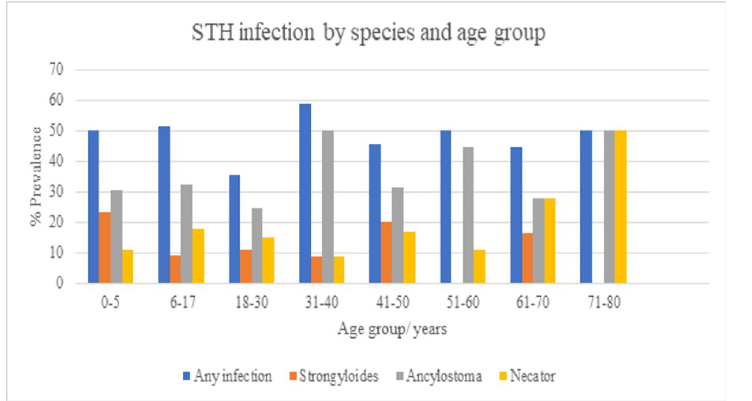
Fig 2. Prevalence of STH species by qPCR by age